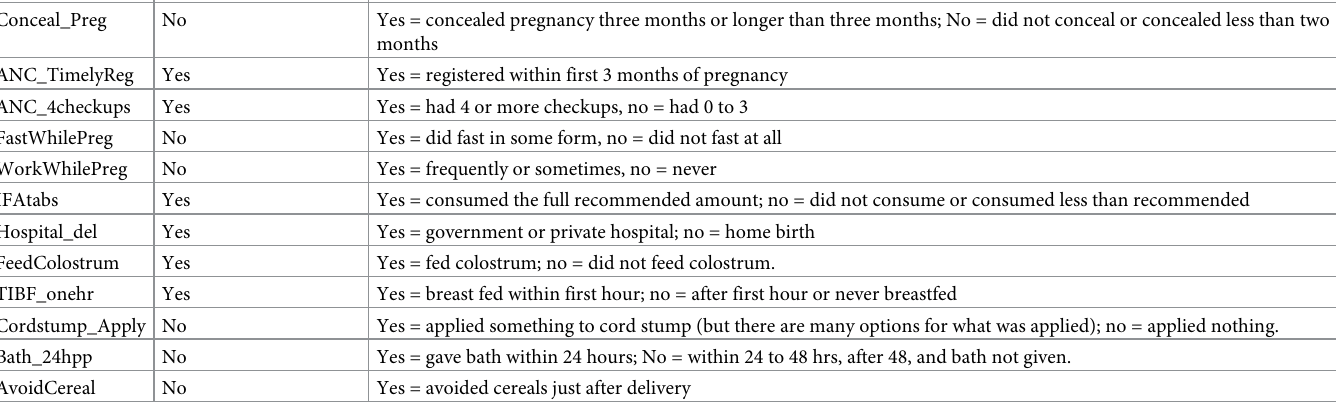
Table 1. Definitions and coding for each of the perinatal behaviors analyzed in this study. The behaviors are ordered in approximate chronological order, with early pregnancy at the top of the table and postpartum behaviors at the bottom. The ‘Recommended response’ column indicates if doing the behavior was biomedically recom- mended or